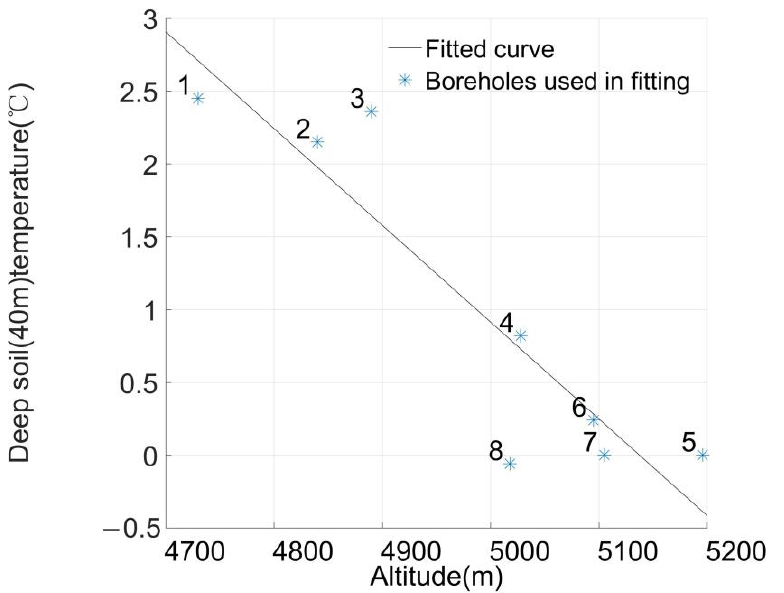
Figure 6. Linear regression curve of Deep soil temperature (DST) (40 m) and altitude in the Gaize area.